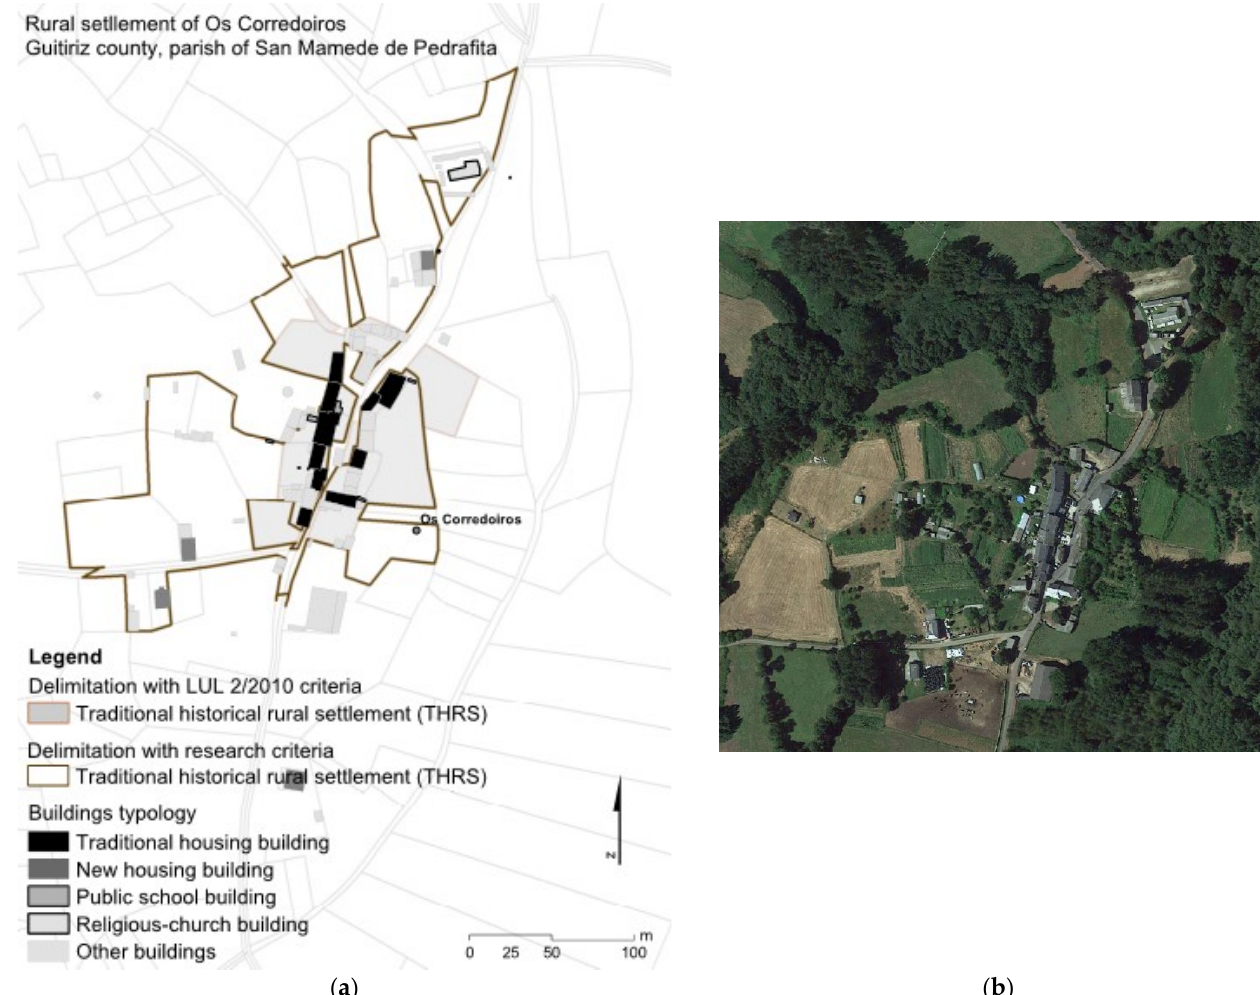
Figure 5 . Delimitations according to LUL 2/2010 and the research criteria applied to RS of Os Corredoiros ( a ). Aerial photo view of the RS on the right ( b ).